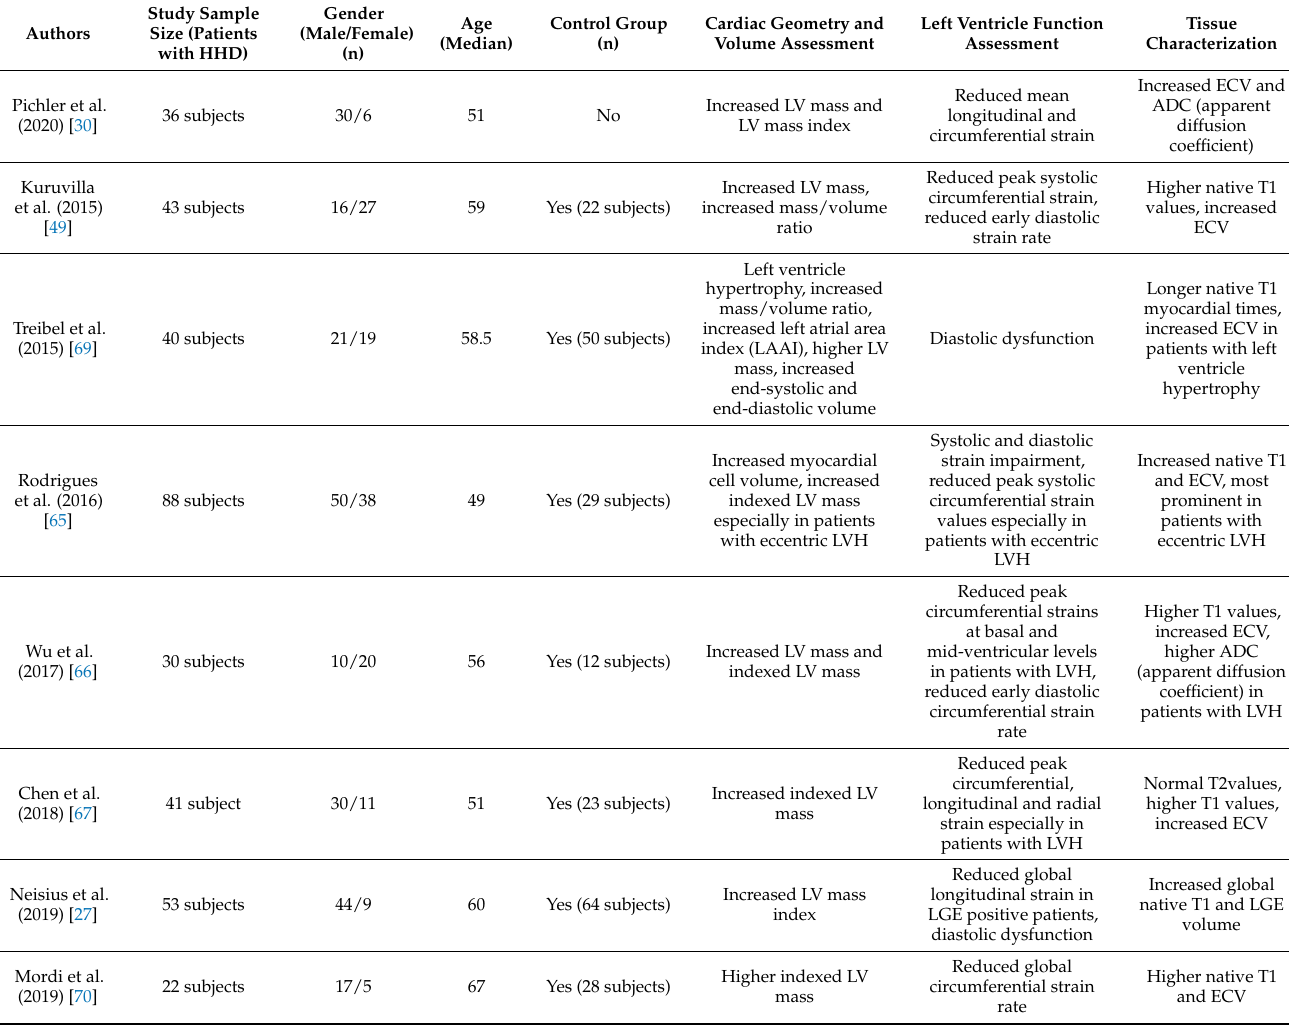
Table 3. The most significant findings on cardiac magnetic resonance in patients with hypertensive heart disease validated across various studies in recent